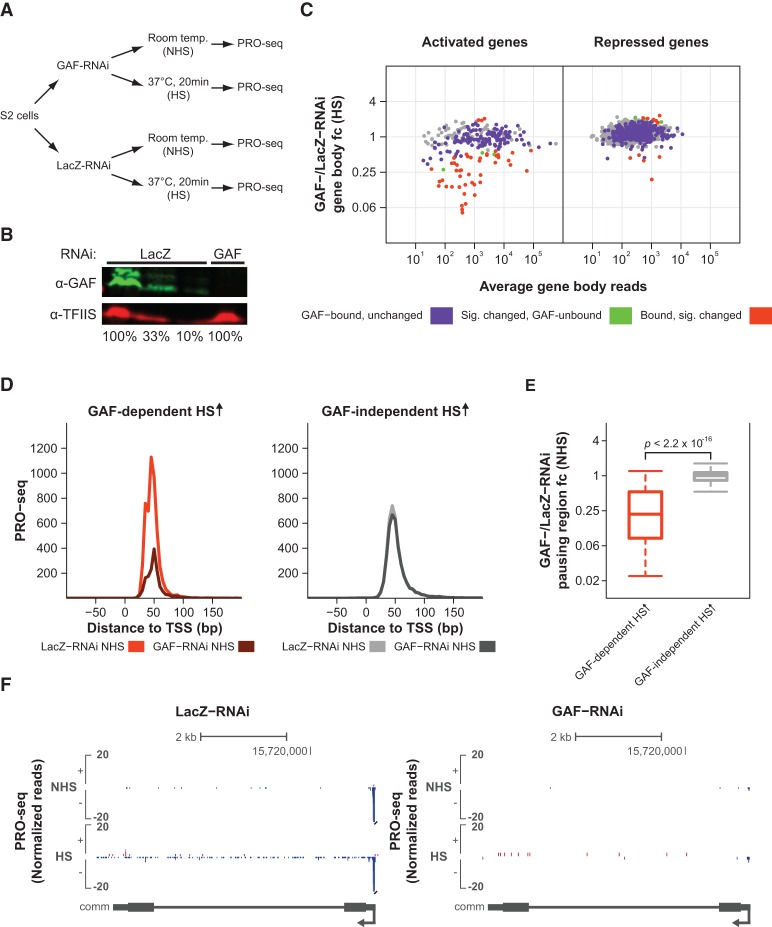
GAF's role in HS activation correlates with its function in establishing promoter-proximal pausing prior to HS. (A) Experimental setup. Drosophila S2 cells were treated with either GAF-RNAi or LacZ-RNAi for 5 d. Nuclei were then isolated for PRO-seq after cells were incubated at room temperature (NHS) or heat-shocked for 20 min (HS). (B) Western blot of whole-cell extracts from LacZ-RNAi-treated and GAF-RNAi-treated cells using antibodies detecting GAF and TFIIS (loading control). One-hundred percent is equivalent to 1.5 × 106 cells. (C) DESeq2 analysis to determine the effect of GAF-RNAi treatment on the PRO-seq gene body reads after HS for the HS-activated (n = 249) and HS-repressed (n = 2300) classes. DESeq2 was used to identify significantly changed genes between GAF-RNAi HS and LacZ-RNAi HS cells, and the results are displayed as MA plots. Significantly changed genes were defined using an FDR of 0.001. GAF-bound genes are labeled in purple, significantly changed genes (according to DESeq2) are labeled in green, and genes that are both GAF-bound and significantly changed are labeled in orange. (fc) Fold change. (D) PRO-seq read density between −100 and +200 bp to the TSS (in 5-bp bins) for the LacZ-RNAi NHS and GAF-RNAi NHS treatments of genes with GAF-dependent (n = 44) or GAF-independent (n = 199) HS activation (HS ↑). (E) Box plot showing the GAF-/LacZ-RNAi pausing region fold change prior to HS (NHS) for genes with GAF-dependent or GAF-independent HS activation. Mann-Whitney U-test, P-value < 2.2 × 10−16. Over 70% of the genes with GAF-dependent HS activation have significantly reduced pausing upon GAF depletion prior to HS, while only 15% of the GAF-independent genes were significantly affected. (F) Representative view in the UCSC genome browser (Kent et al. 2002) of a gene with GAF-dependent pausing prior to HS whose activation is inhibited by GAF-RNAi treatment. PRO-seq normalized reads for the different RNAi treatments (LacZ and GAF) before and after HS for the plus strand are shown in red, and those for the minus strand are shown in blue. Gene annotations are shown at the bottom.